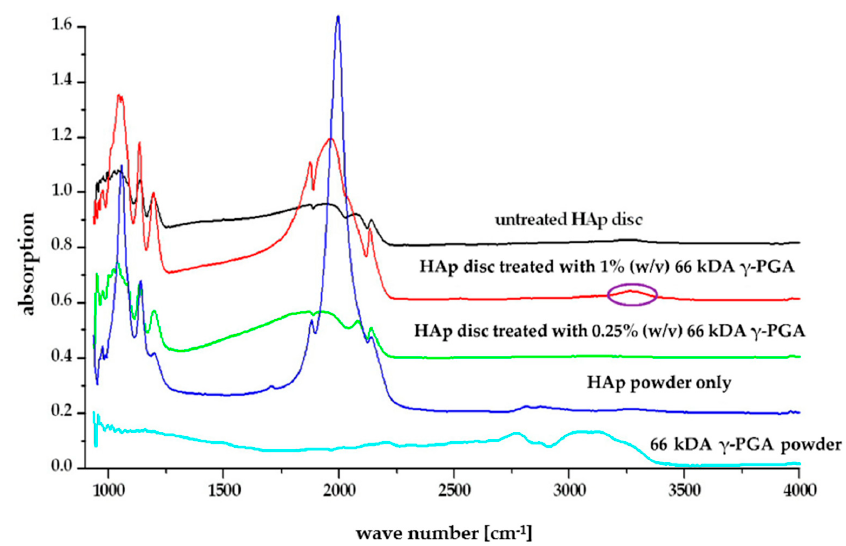
12 of 19 Figure 6. Comparison of the ISE pilot study result showing the Ca 2+ activity from HAp disc (20% porous) protected by different commercial γ -PGAs at 0.1, 0.25 and 1% (w/v). n = 3. Error bars indi- cate standard error values. From Figure 6 it appeared that better protection was achieved with 1% (w/v) formu- lations compared to 0.25% (w/v) formulations. Hence, we came to the conclusion that, regardless of chemical properties (Table 2), 1% (w/v) γ -PGA formulations were the most suitable in protecting HAp from dissolution across the range tested (0.1, 0.25, 0.5, 1, 2, 3